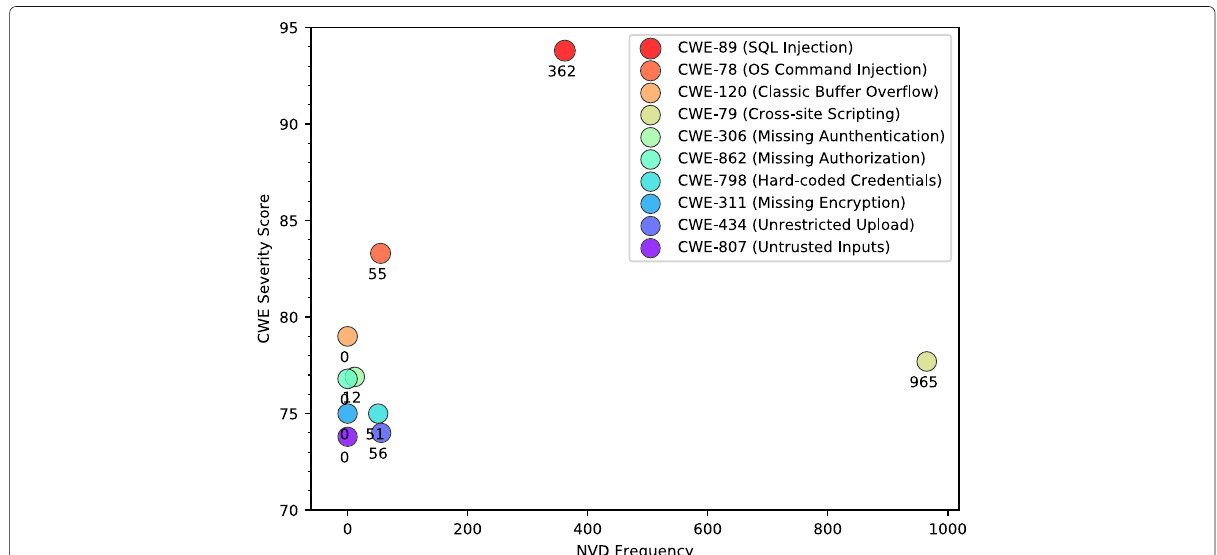
Fig. 2 Number of vulnerabilities in the NVD 2017 List that were caused by the top 10 SANS/CWE of 2011. The plot also shows the CWE severity score for each CWE